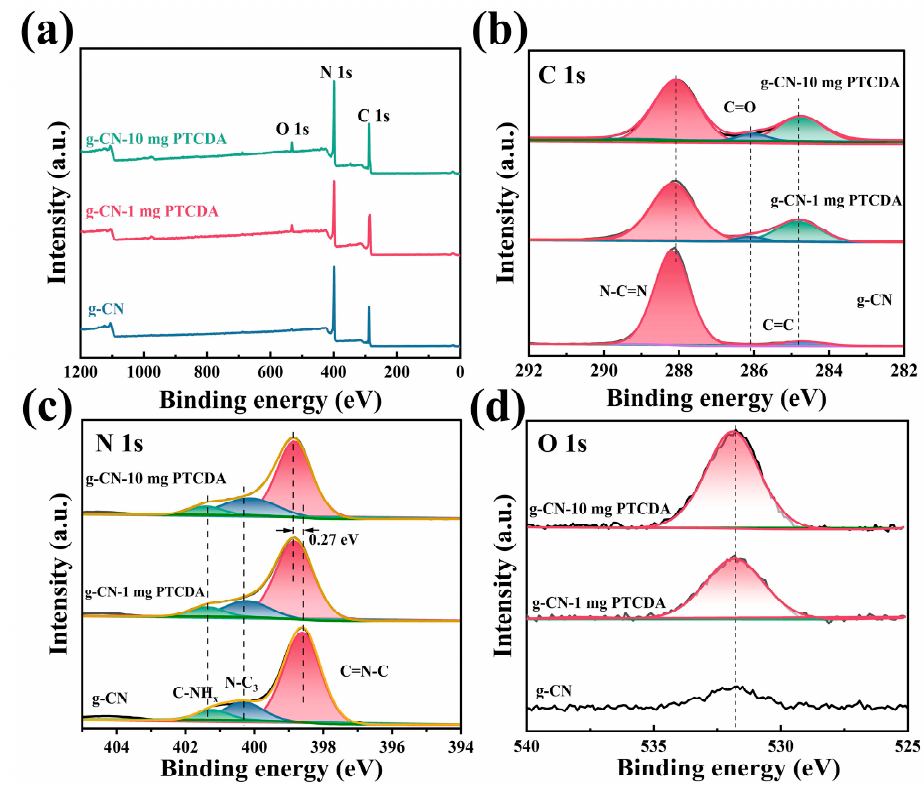
Figure 3. XPS-survey ( a ), high-resolution of C 1s ( b ), N 1s spectra ( c ), and O 1s spectra ( d ) of the samples of g-CN, g-CN-1 mg PTCDA, and g-CN-10 mg-PTCDA. UV-vis DRS spectra were conducted to study the optical absorption properties of the g-CN and g-CN- x mg PTCDA. As shown in Figure 4a, the absorption band edges of g-CN- x mg PTCDA ( x = 1, 10, 100, 1000) are gradually red-shifted, and the visible-light response range steadily expanded to the full spectra region accompanying the amount of PTCDA raised, fully indicating that PTCDA covalently connected with g-CN via imide bonds. The corresponding band gaps of g-CN- x mg PTCDA ( x = 1, 10) are respectively calculated as 2.51, 2.44 eV based on the Tauc plots method (Figure 4b), and they are narrower than the 2.75 eV of g-CN, which can be explained by the π electrons being delocalized along the expanded conjugation system between PTCDA and